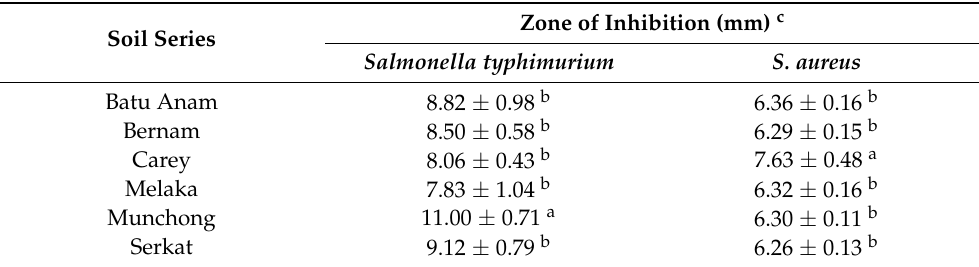
Table 1. Zones of inhibition of untreated clay leachates obtained from six soil series against Salmonella typhimurium and S. aureus .